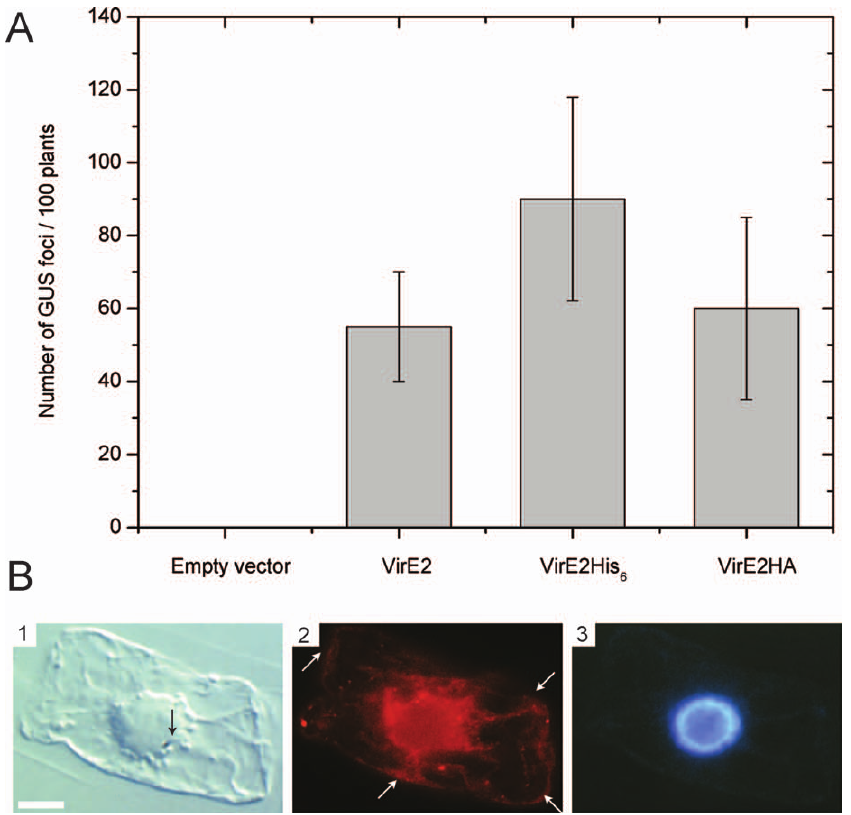
Figure 4. Localization of Active VirE2 Protein Transiently Expressed in Tobacco BY-2 cells (A) Tobacco plants were transformed with empty CAMBIA vector or CAMBIA vector allowing expression of VirE2, VirE2HA, or VirE2 His 6 . These transgenic plants were then used for transient T-DNA transfer assay. In this assay, the Agrobacterium strain lacking the virE2 gene was used to infect the plants and the VirE2 protein in the plant, if active complements the missing VirE2 activity of bacterium-origin. The T-DNA is also carrying a reporter gene which transfer can be detected by the appearance of blue spots (GUS) on plants. One can observe that all the VirE2 variants used in this study are active as they allow complementation of the Agrobacterium strain lacking the VirE2 gene. (B) (1) Tobacco BY-2 cell transformed by gold particles bombardment observed in Nomarski. The gold particle (located in the nucleus) is indicated by an arrow. The scale bar represents 10 l m. (2) Localization of VirE2. VirE2 is present around the nucleus, in cytoplasmic strands, representing a soluble, cytoplasmic pool of protein also visible at the cell periphery (white arrows) and in a few cytoplasmic spots. (3) DAPI staining of the nucleus of